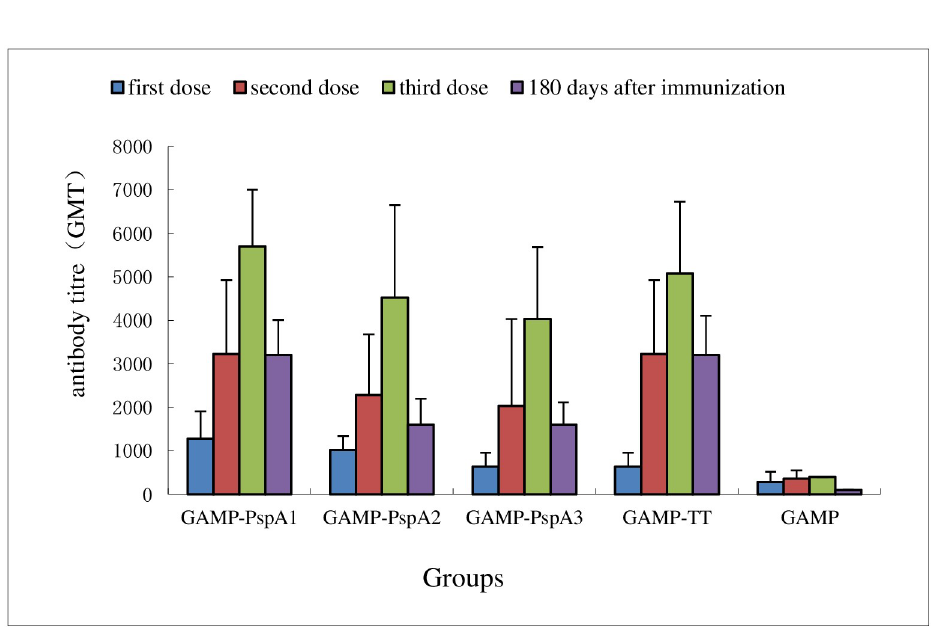
Fig 2. Results of anti-GAMP IgG antibody responses after the first, second, and third doses, and 180 days after the first immunization. The results were expressed as the reciprocal of geometric mean titer (GMT).